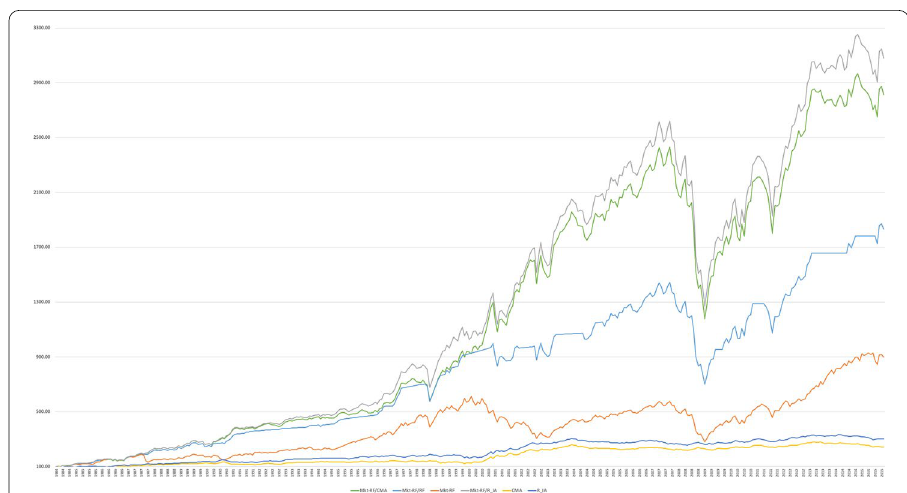
Fig. 3 Performance of alternative trading strategies. The Figure presents the performance of alternative trading strategies based on $100 invested in May 1984. The strategies are based on past signals from net exchanges. For each month t, I calculate the average over NEIO (normalized net exchanges) from period t-2 to t-4. I use the average as an indicator to determine my investment decision in month t. If on average the past net exchanges have been negative, I invest all my funds in the market portfolio and short the risk-free asset (30-day T-bills). If on average the past net exchanges have been positive, I invest all my funds in the respective factor